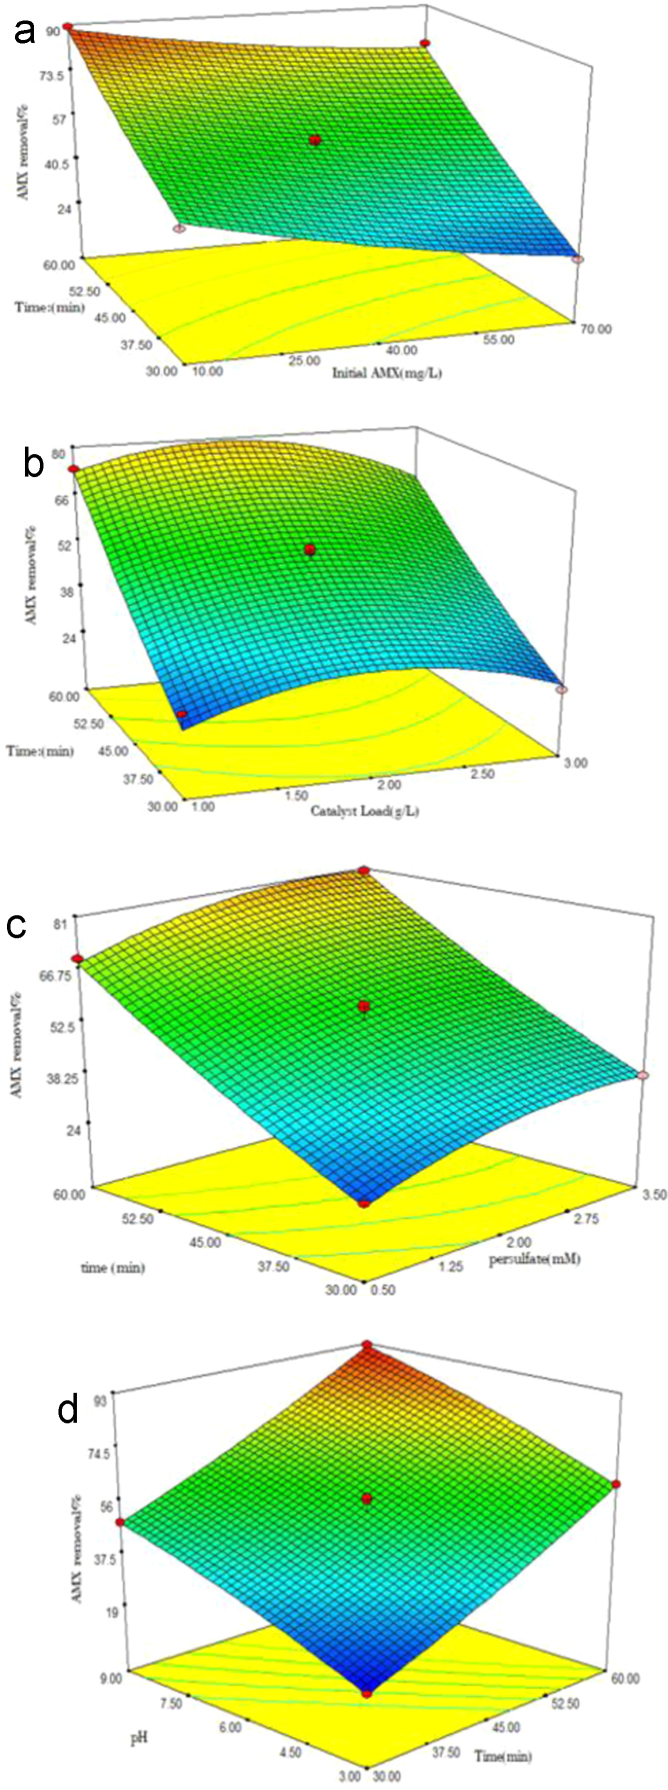
Response surface plots for AMX removal by UV/Na2S2O8/FeS2 (a) AMX removal versus initial AMX and time (b) AMX removal versus AMX catalyst load and time (c) AMX removal versus persulfate dose and time (d) AMX removal versus pH and time.